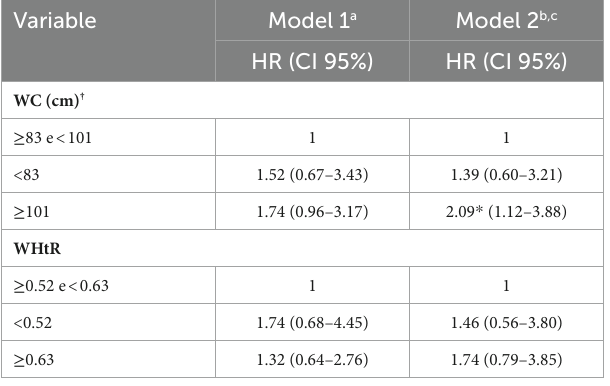
TABLE 3 Simple and multiple analyses of the association between waist circumference (WC) and waist-to-height ratio (WHtR) and CVD mortality older adults. Viçosa, MG, Brazil,